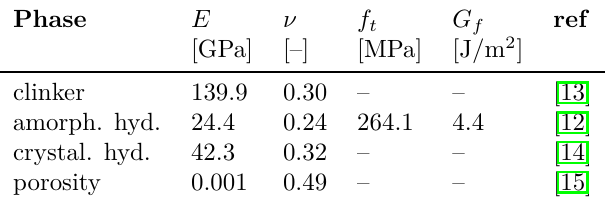
Table 2. Material properties obtained from nanoin- dentation.